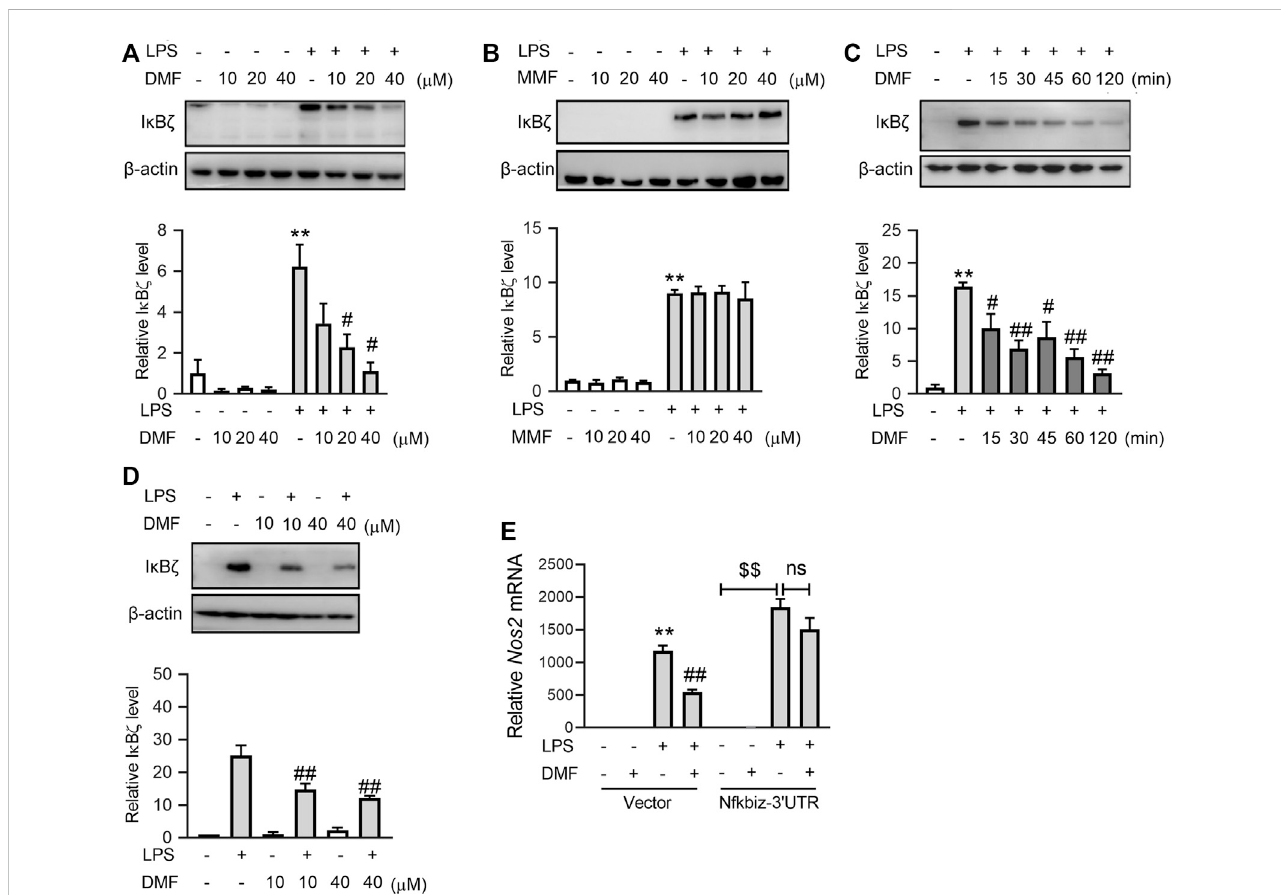
I κ B ζ fromtheindicatedgroups( n =3). (C) RAW264.7cellswerepretreatedwith40 μ MDMFfortheindicatedtimeandthenstimulatedwith1 μ g/mLLPSinthe absence of DMF for 1 h. Western blot analysis and quanti fi cation of I κ B ζ from the indicated groups ( n = 4). (D) RAW264.7 cells were transiently